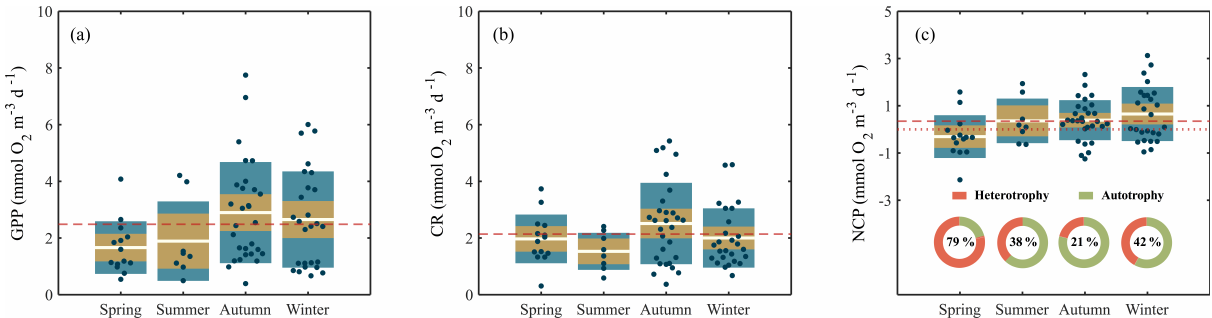
Figure 5. Seasonal variability of (a) gross primary production (GPP), (b) community respiration (CR), and (c) net community production (NCP) measured along the Red Sea. Boxplots indicate the 95% confidence intervals (in lighter colour) with ± 1SD (dark shaded). The central horizontal white lines in the box mark the mean value for each season. The red dashed lines represent the overall mean while the red dotted line in (c) defines the limit between autotrophic and heterotrophic communities (NCP = 0). Values inside the doughnut plots (c) indicate the percentage of heterotrophy (NCP<0) for each season.